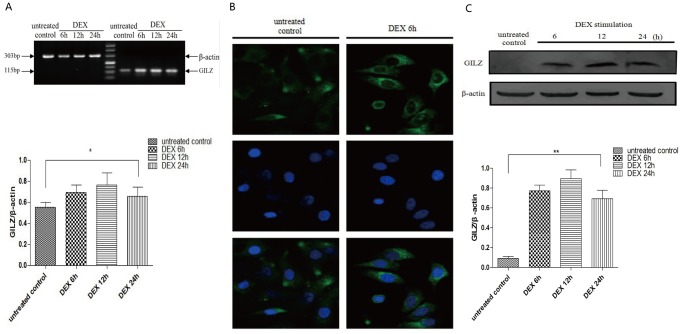
The effect of DEX on GILZ mRNA and GILZ protein expression in 9HTE cells.(A) RT-PCR was performed to detect the GILZ mRNA level and showed that DEX induced the expression of GILZ mRNA starting from 6 h until 24 h (for 24 h, 0.553±0.048 in the untreated group compared with 0.658±0.087 in the DEX-treated, *P<0.05, n = 8). (B) 9HTE cells were treated with or without DEX for 6 h, and GILZ was located using immunofluorescence (400×). (C) Western blot was performed to determine the expression levels of GILZ protein from 6 h until 24 h with DEX (for 24 h, 0.092±0.019 in the untreated group compared with 0.693±0.085 in the DEX-treated, **P<0.001, n = 3). β-actin was used as the loading control.